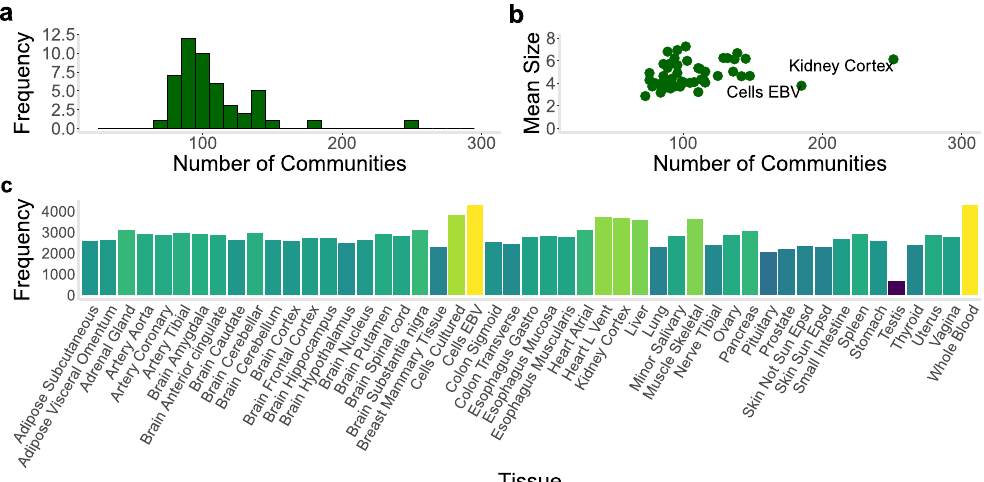
Fig. 3 Summary statistics on identi fi ed communities. a Histogram shows the distribution of community count in the various tissues (mean = 108, SD = 31). b The scatter plot displays the community count and mean community size for each tissue, showing a signi fi cant correlation (Spearman ρ = 0.39, p = 0.006). The highest number of communities was observed in "Kidney Cortex'' ( n = 251). c Plot provides the number of genes that belong to a community in each tissue. The nonsolid tissues, "Cells EBV'' and "Whole Blood'', show the highest number of genes with membership in a